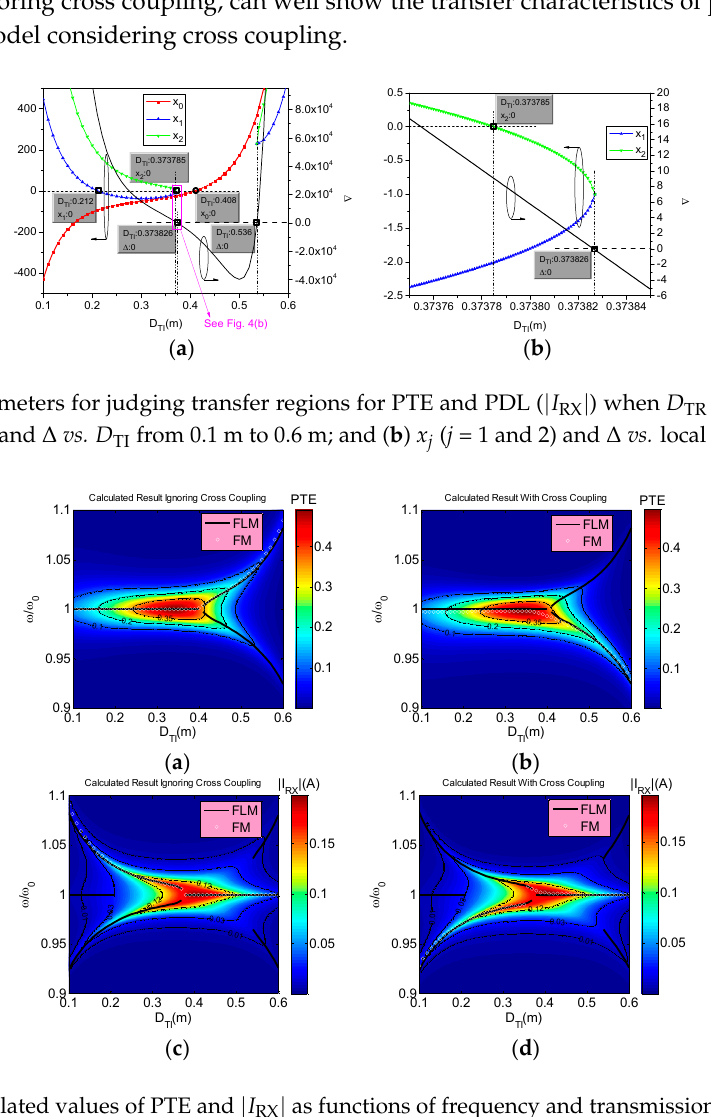
Figure 5. Simulated values of PTE and | I RX | as functions of frequency and transmission distance, D TI , when D TR = 0.7 m: ( a ) PTE vs. ω / ω 0 and D TI under ignoring cross coupling; ( b ) PTE vs. ω / ω 0 and D TI under considering cross coupling; ( c ) | I RX | vs. ω / ω 0 and D TI under ignoring cross coupling; and ( d ) | I RX | vs. ω / ω 0 and D TI under considering cross coupling.